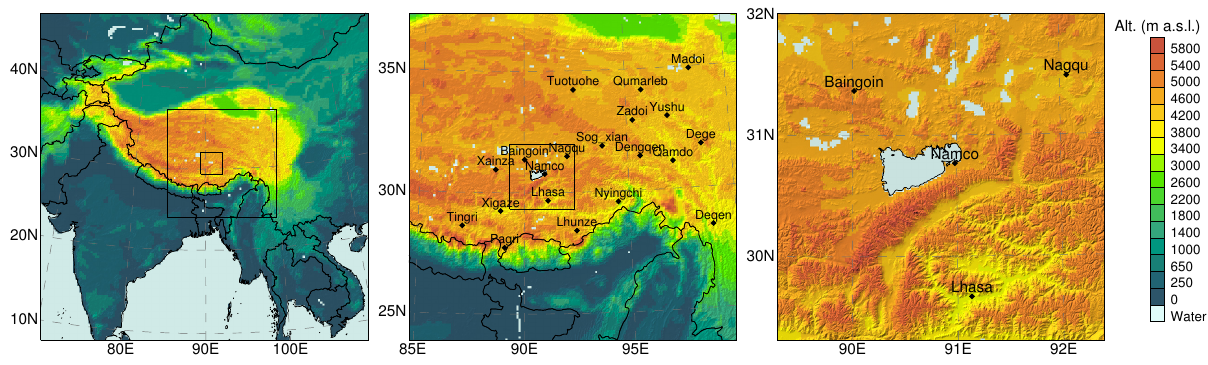
Fig. 1. WRF domains and model topography. Left: large domain (LD); the medium (MD) and small (SD) are indicated by black frames. Center: medium domain. Right: small domain. Black dots represent the locations of the available weather stations.